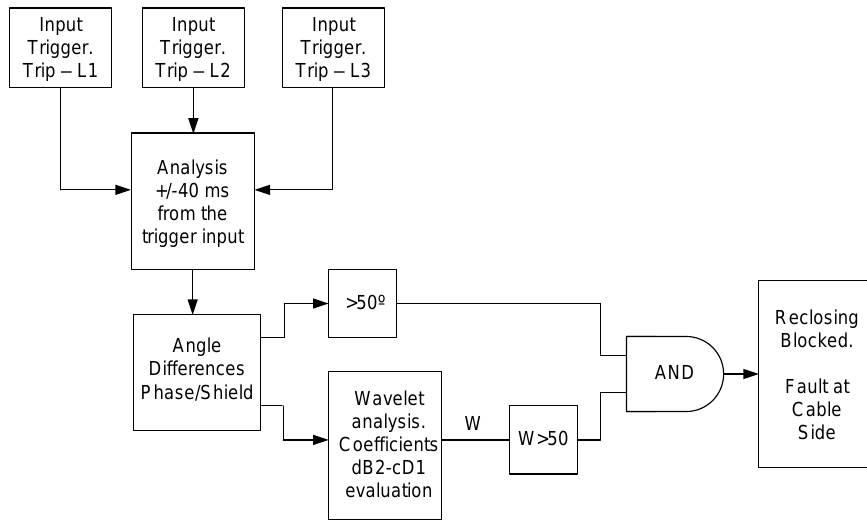
Figure 8. Algorithm of the new auto-reclosing blocking method.